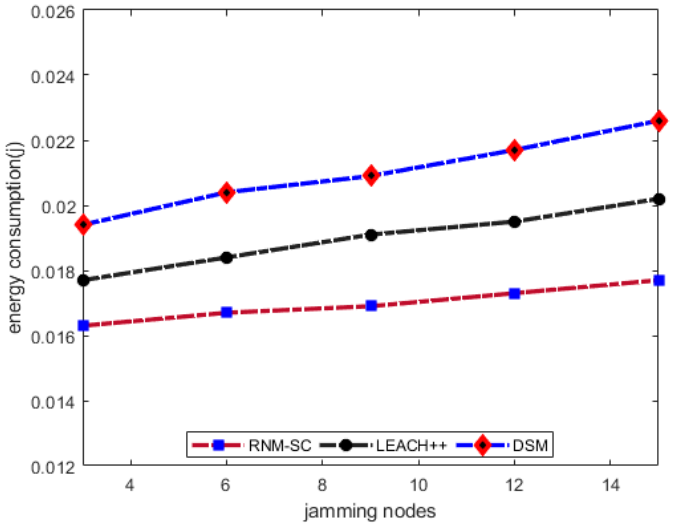
Figure 4. Energy consumption and jamming nodes.